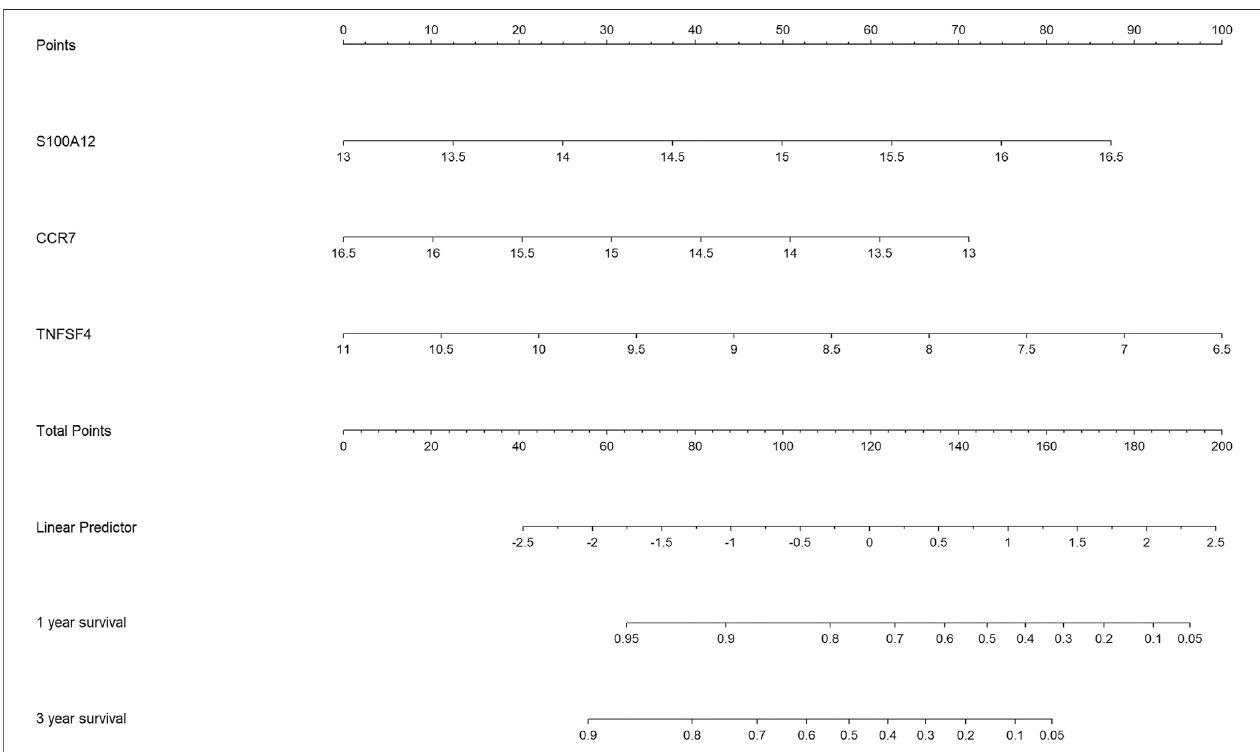
FIGURE 6 | Nomogram for predicting 1- and 3-year overall survival of idiopathic pulmonary fi brosis (IPF) patients in the GSE28042 cohort.